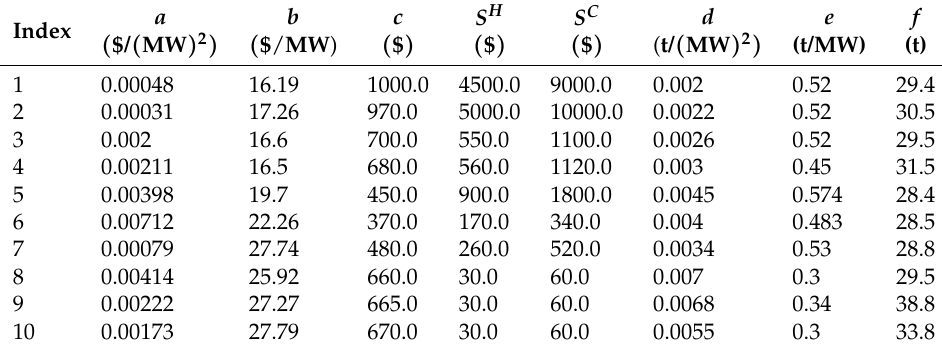
Table A3. 10 units system thermal cost and emission charactoristics.